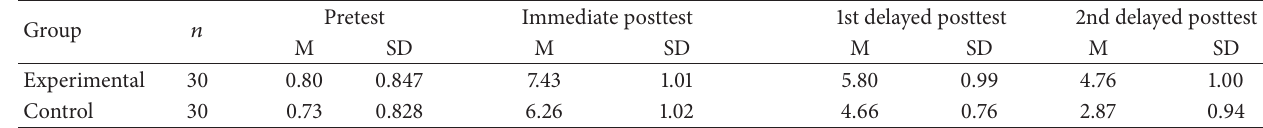
Table 4: Descriptive statistics for the receptive vocabulary tests.